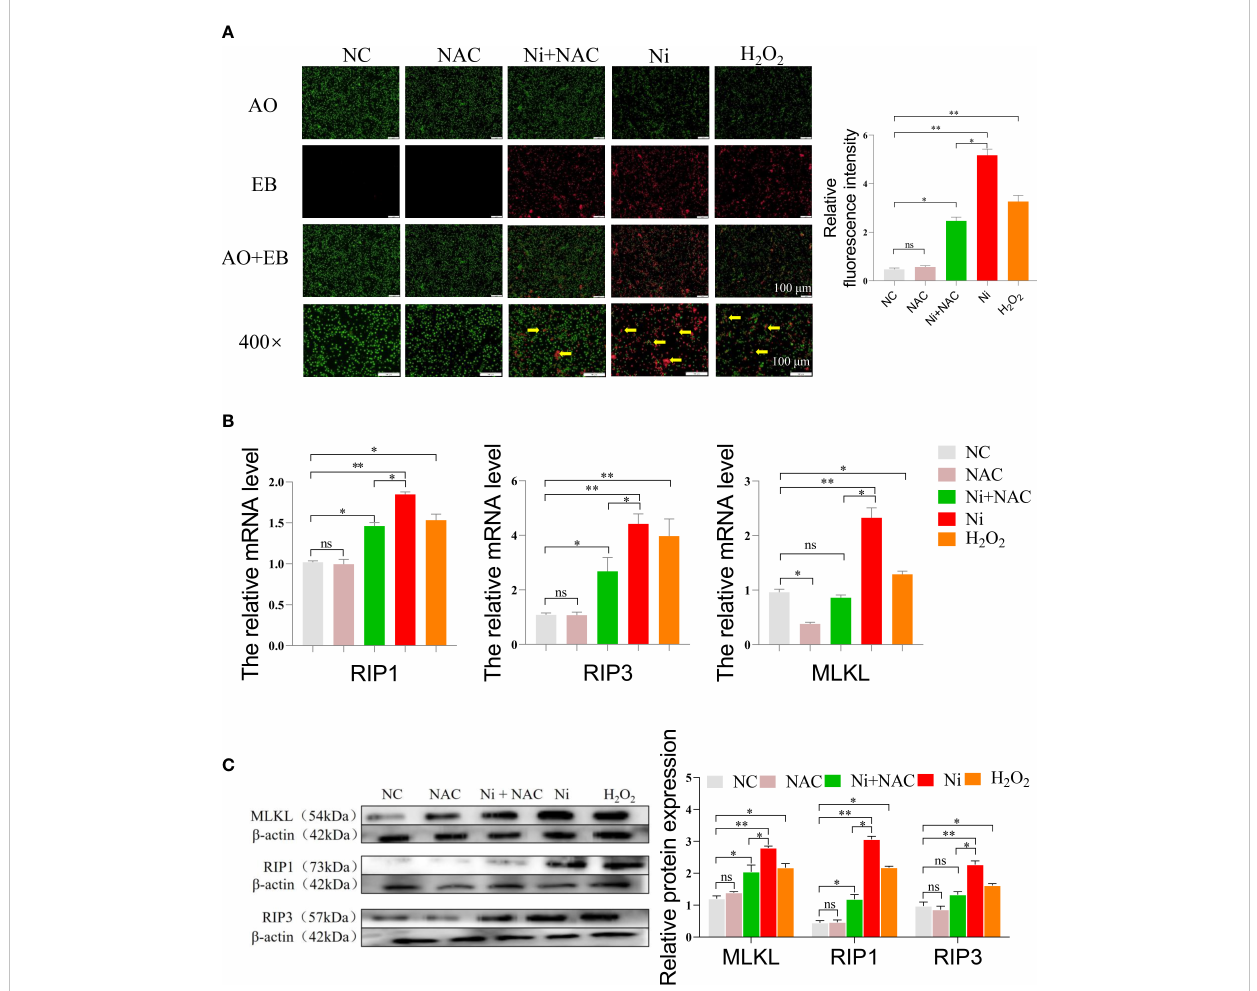
FIGURE 6 (A) AO/EB staining of spleen lymphocytes after exposure to, green dots indicate normal cells, and red dots pointed by the yellow arrow indicate necroptosis cells. (B) The mRNA expression of necroptosis-related genes in spleen lymphocytes exposed to NiCl 2 , H 2 O 2 and NAC. ns represents no statistical difference between the two groups, * represents signi fi cant difference between the two groups (P<0.05), and ** represents extremely signi fi cant difference between the two groups (P<0.01). (C) The protein expression of necroptosis-related genes in spleen lymphocytes exposed to NiCl 2 , H 2 O 2 and